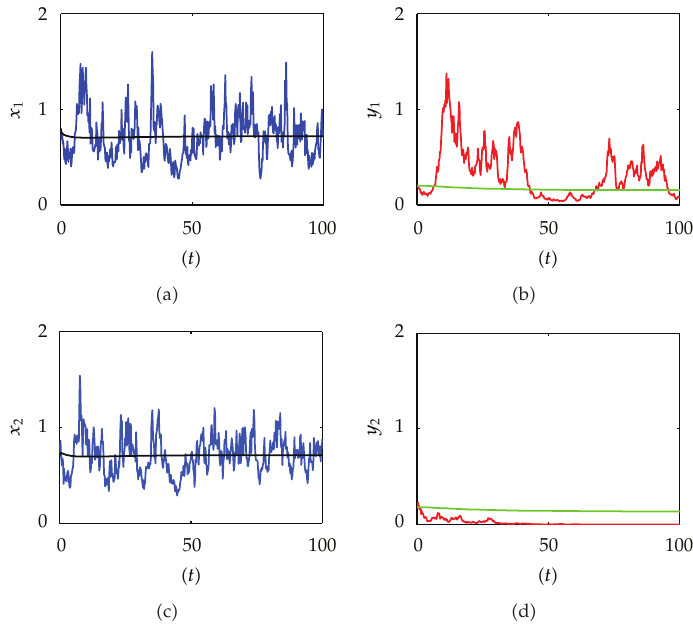
Figure 6: The solution of stochastic system compared to the deterministic system: σ 11 (cid:5) 0 . 4 ,σ 12 (cid:5) 0 . 3 ,σ 21 (cid:5) 0 . 3 ,σ 22 (cid:5) 0 . 4. The predator population y 2 will die out although its corresponding deterministic system is globally stable. The blue and red lines represent the solutions of system (cid:2) 5.1 (cid:3) , and the black and green lines represent the solutions of corresponding undisturb